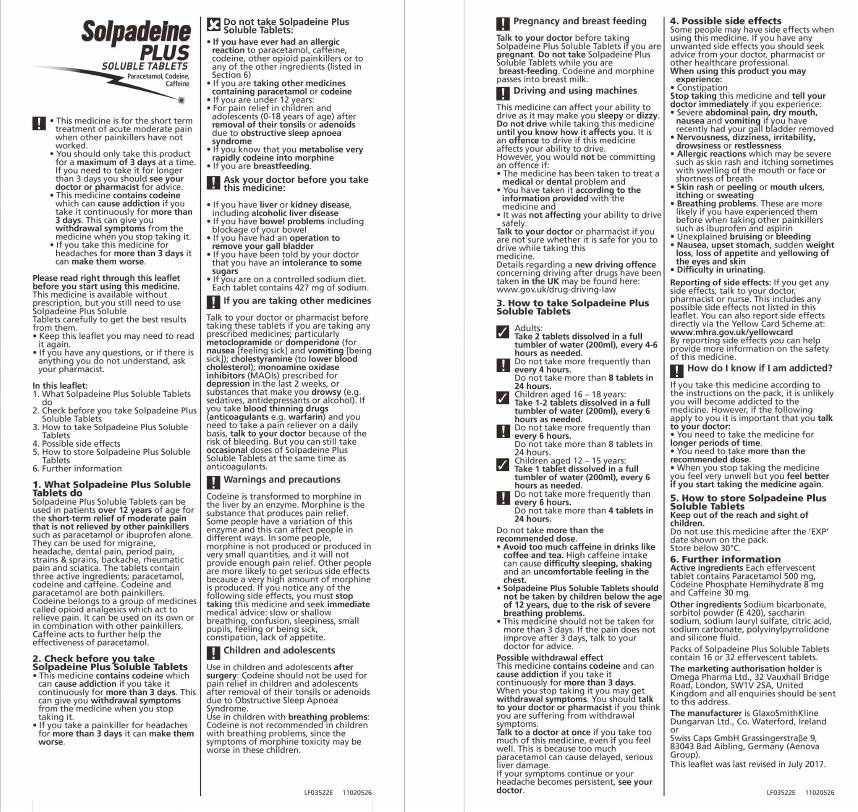
Figure 1. Sample 1